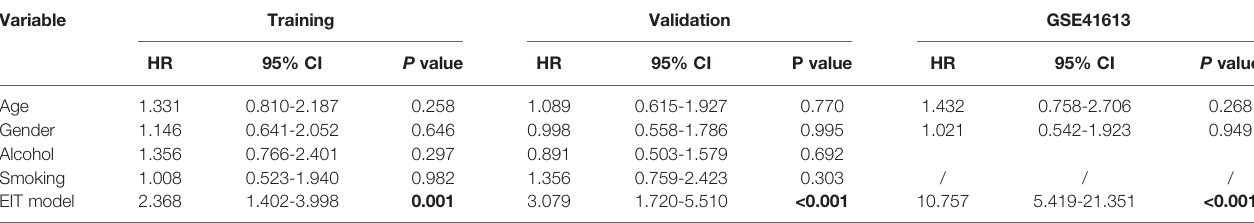
TABLE 1 | Multivariate Cox regression analysis of OSCC patients in the TCGA and GSE41613 datasets.